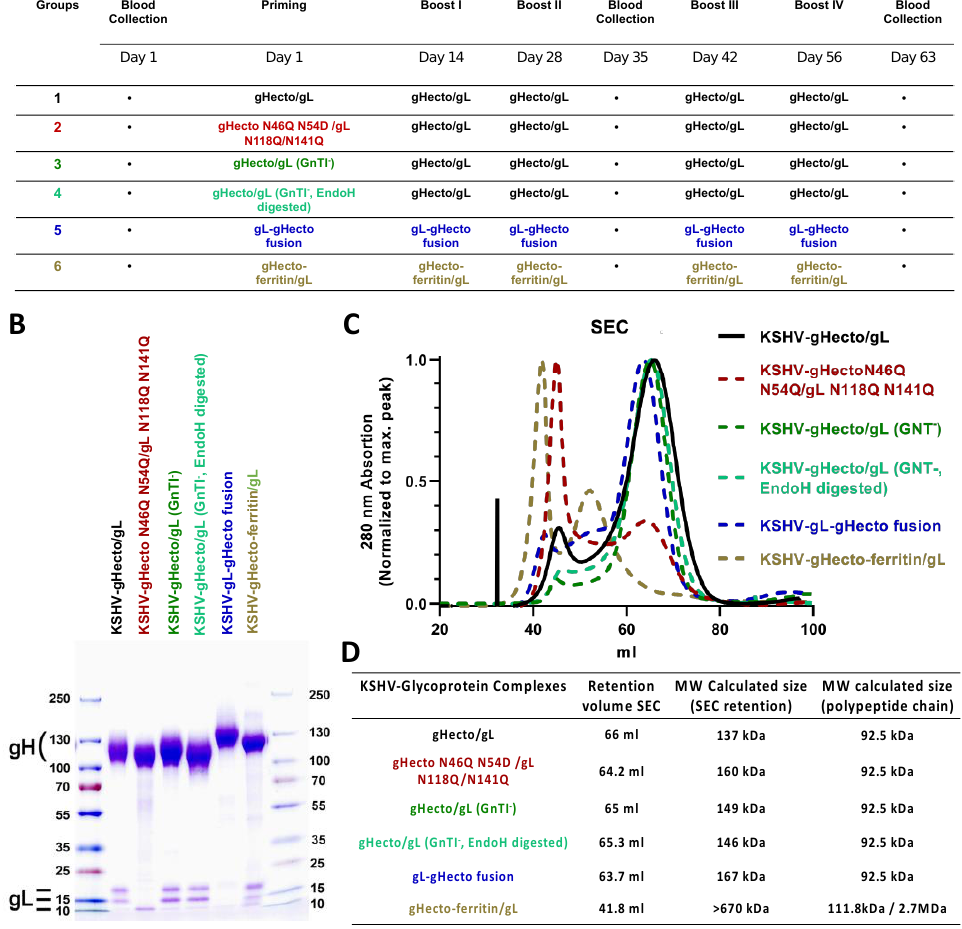
Figure 2. Immunization schedule and gH/gL protein complexes used for immunization. ( A ) Immunization schedule. ( B ) The indicated KSHV gHecto/gL protein complexes were expressed in HEK 293T or GnTI-HEK 293S cells, purified, resolved by SDS PAGE, and stained with colloidal Coomassie. Purified complexes presented a KSHV gH band between 110 and 140 kDa and the three different glycosylation forms of gL between 10 and 20 kDa. ( C ) SEC Chromatograms (HiPrep 16/60 Sephacryl S300HR column (GE)) of the indicated KSHV gHecto/gL protein complexes. ( D ) The retention volume of the different KSHV gHecto/gL complexes and the calculated molecular weight.